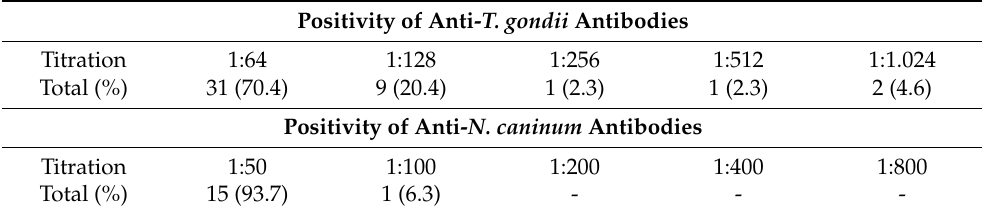
Table 2. Distribution of anti- Toxoplasma gondii and anti- N. caninum antibody titrations by Immunoflu- orescence Antibody Test (IFAT) in traction equids in the semi-arid region of Northeastern